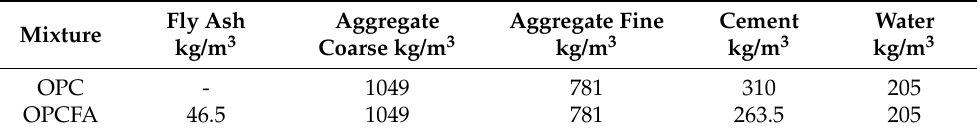
Table 2. Dosage of conventional concrete and sustainable concrete, (kg/m 3 of concrete, ratio w/c =